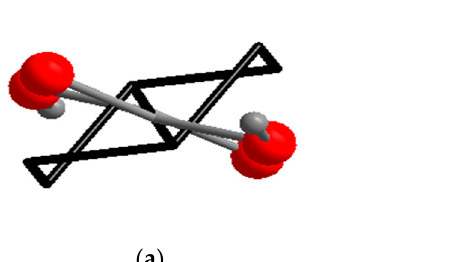
Figure A1. Packing of H 2 chdc molecules in 6 (CCDC 1973668) ( a ) and the previously reported H 2 chdc ( b ). Hydrogen bonds are shown in orange.